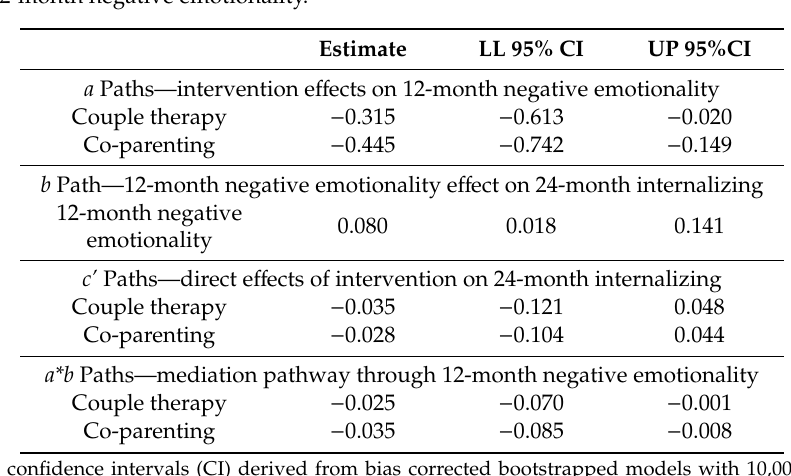
Figure 1. Model estimates (SE) for e ff ects of intervention on reduced negative emotionality at 12-months and reduced infant internalizing symptoms at 24-months. Single-headed black arrows represent significant paths. Single-headed gray arrows represent non-significant paths. Table 4. Mediation pathways of intervention groups predicting 24-month internalizing symptoms through 12-month negative emotionality.